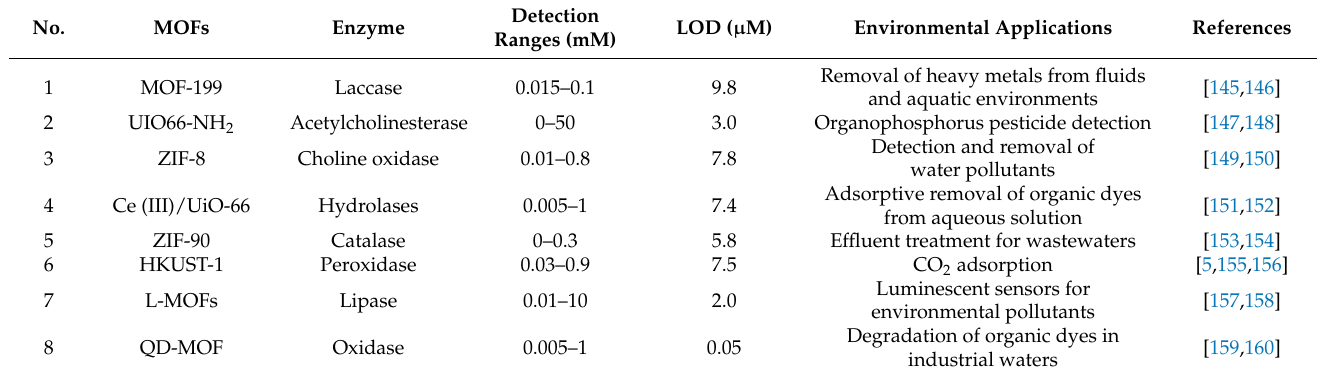
Table 3. Summary of environmental applications of enzyme–MOF composites described in the scientific